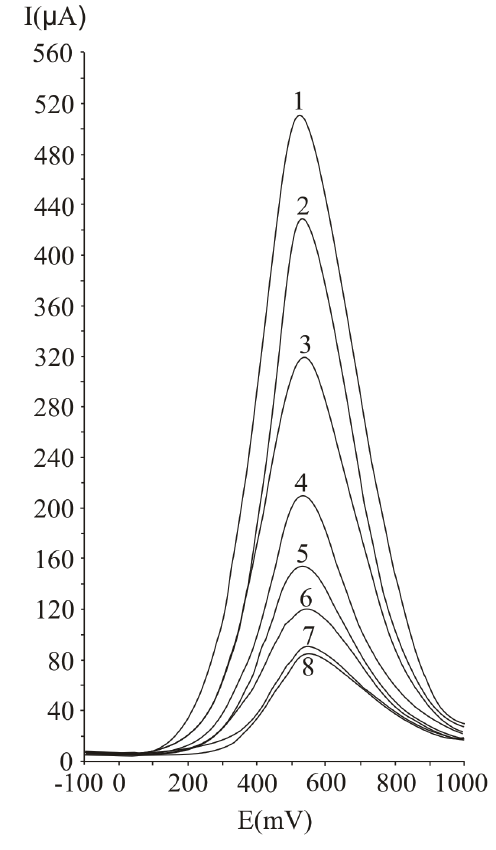
Figure 1. Differential pulse voltammograms obtained with a Pt working electrode for different ascorbic acid concentrations, expressed as mM: 20 (1), 15 (2), 10 (3), 5 (4), 2.5 (5), 1.25 (6), 0.625 (7) and 0.31 (8); experimental conditions: pulse amplitude 75 mV, pulse period 125 ms, potential scan rate 50 mV/s.